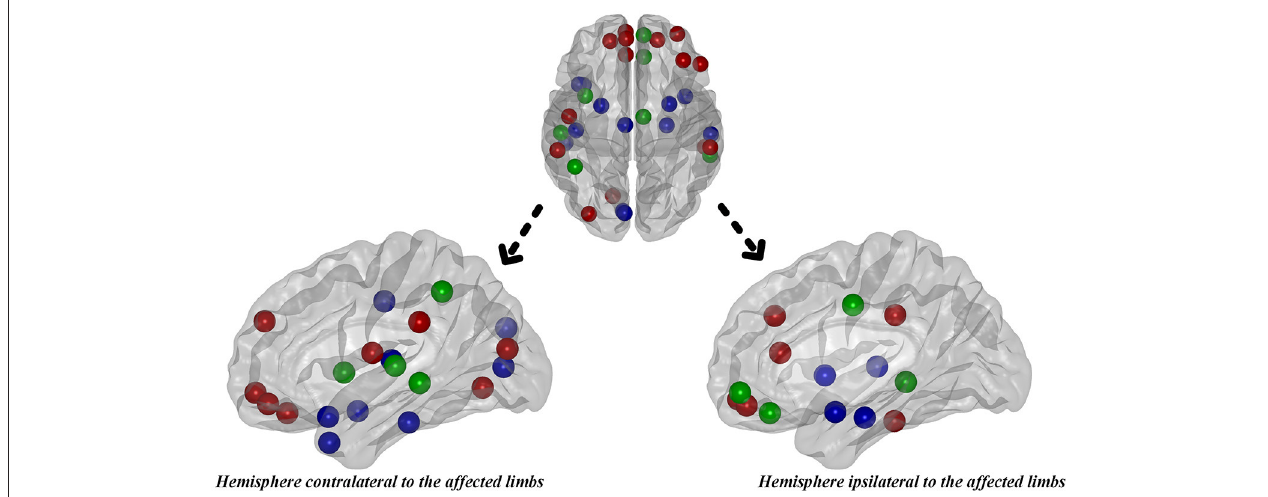
FIGURE 6 | The distribution of hubs in PD patients with hemiparkinsonism. Green color represented the overlapped hubs in both groups; red color represented the regenerated hubs in patient group and blue color represented the disrupted hubs in patient